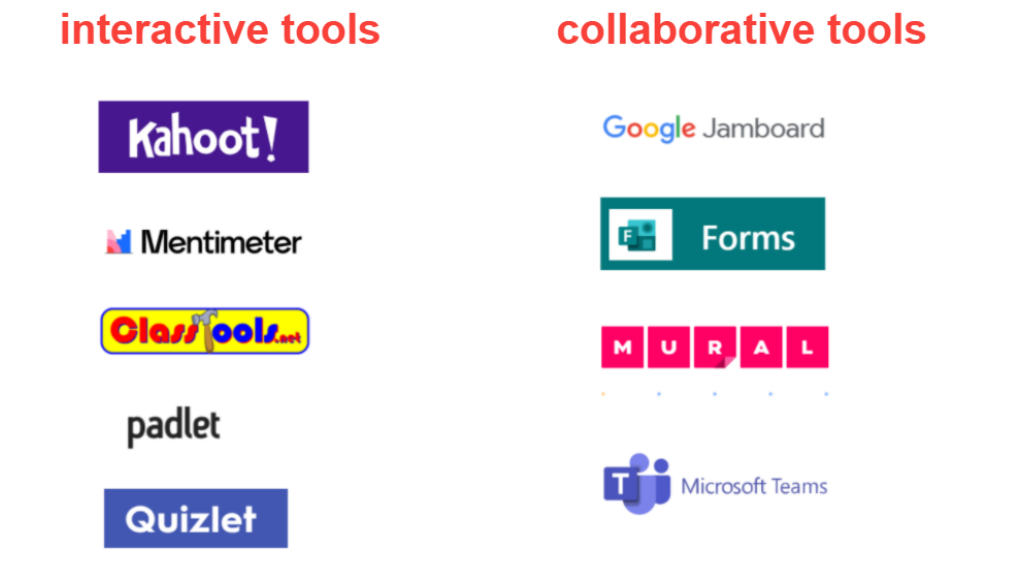
FIGURE 1. INTERACTIVE AND COLLABORATIVE DIGITAL TOOLS USED TO ENHANCE STUDENTS